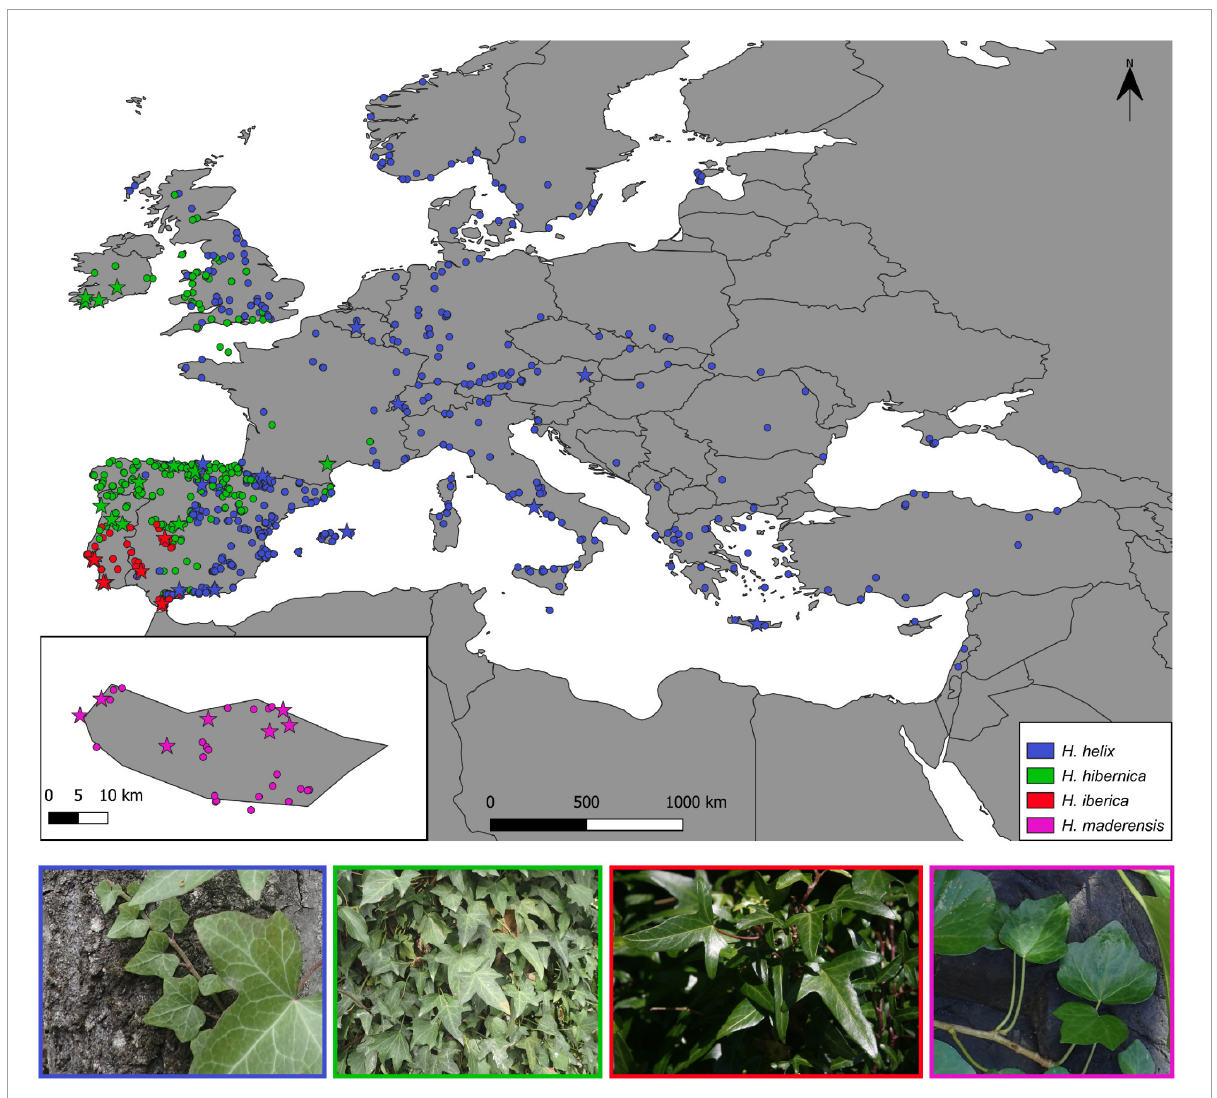
FIGURE1 Occurrence-based map of the distribution ranges of the three species of the western polyploidy clade of Hedera ( H. hibernica , H. iberica , H. maderensis ) and H. helix . Circles indicate samples included for the climatic niche study. Stars indicate samples also included in the phylogenetic